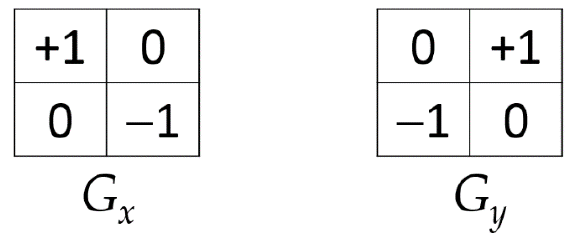
Figure A4. 2 × 2 masks of RED.